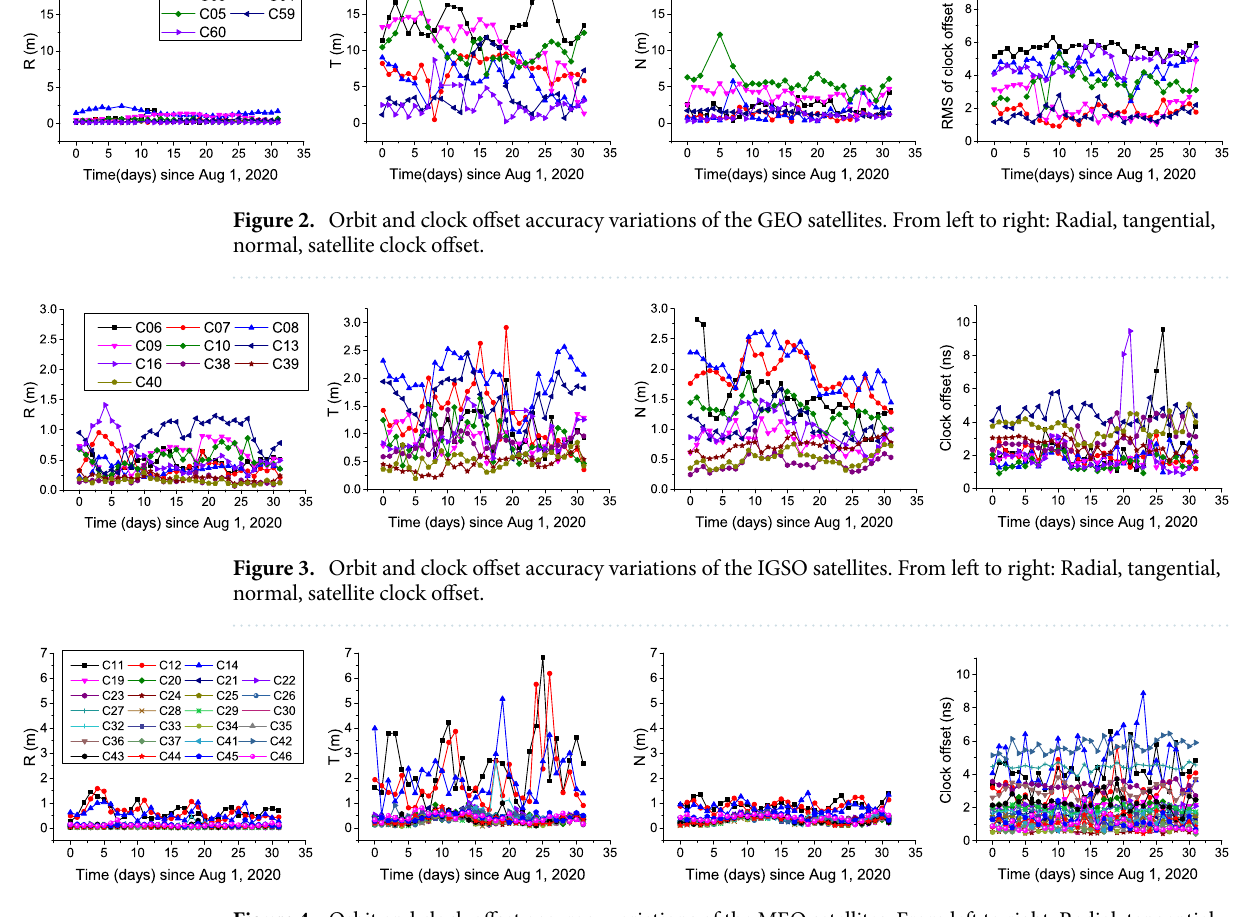
Figure 4. Orbit and clock offset accuracy variations of the MEO satellites. From left to right: Radial, tangential, normal, satellite clock